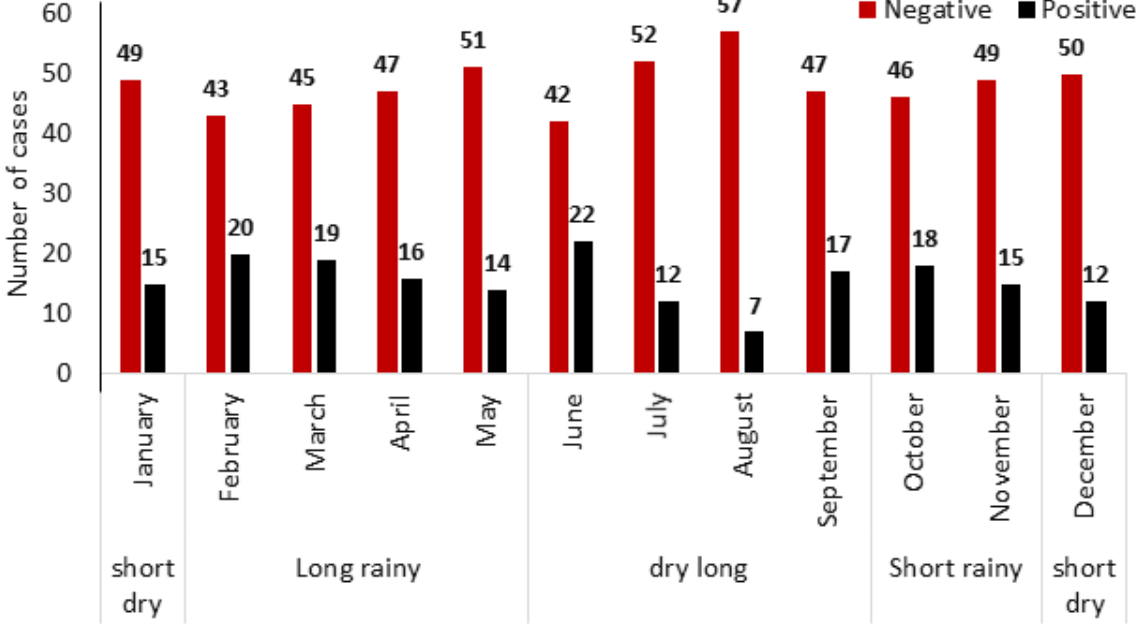
Figure 1. Malaria cases during the study period from January to December 2021